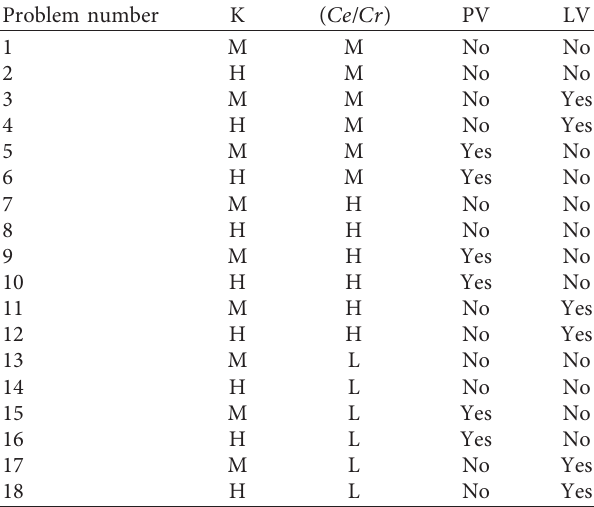
Test6 N : number of customer classes; T : planning periods. Table 3: Specifications of different groups of problems. Problem number